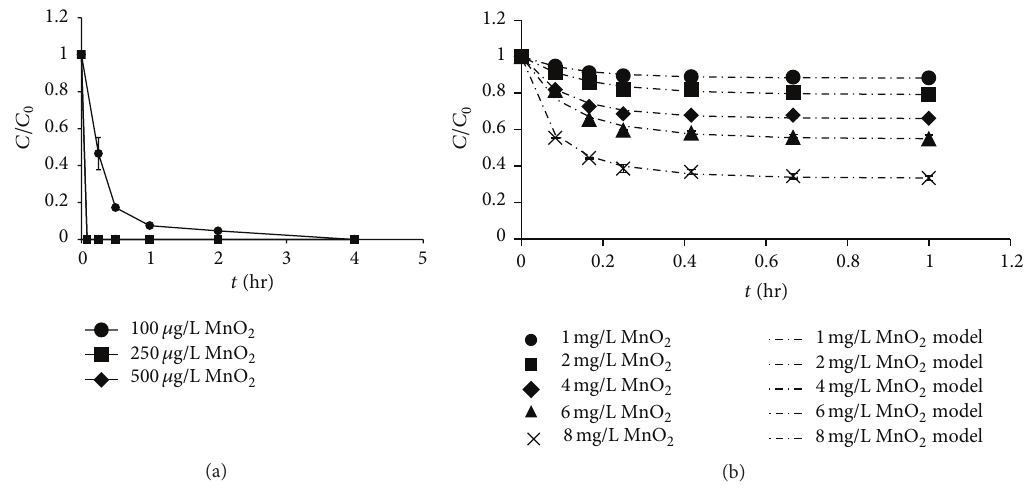
Figure 3: Effect of MnO 2 loading on the oxidation of controlled substances by MnO 2 : (a) morphine and (b) codeine (morphine and codeine = 100 𝜇 g/L, pH = 7, and ionic strength = 10mM) (the second-order kinetic model developed by Zhang et al. [11] was fitted to describe the codeine oxidation).